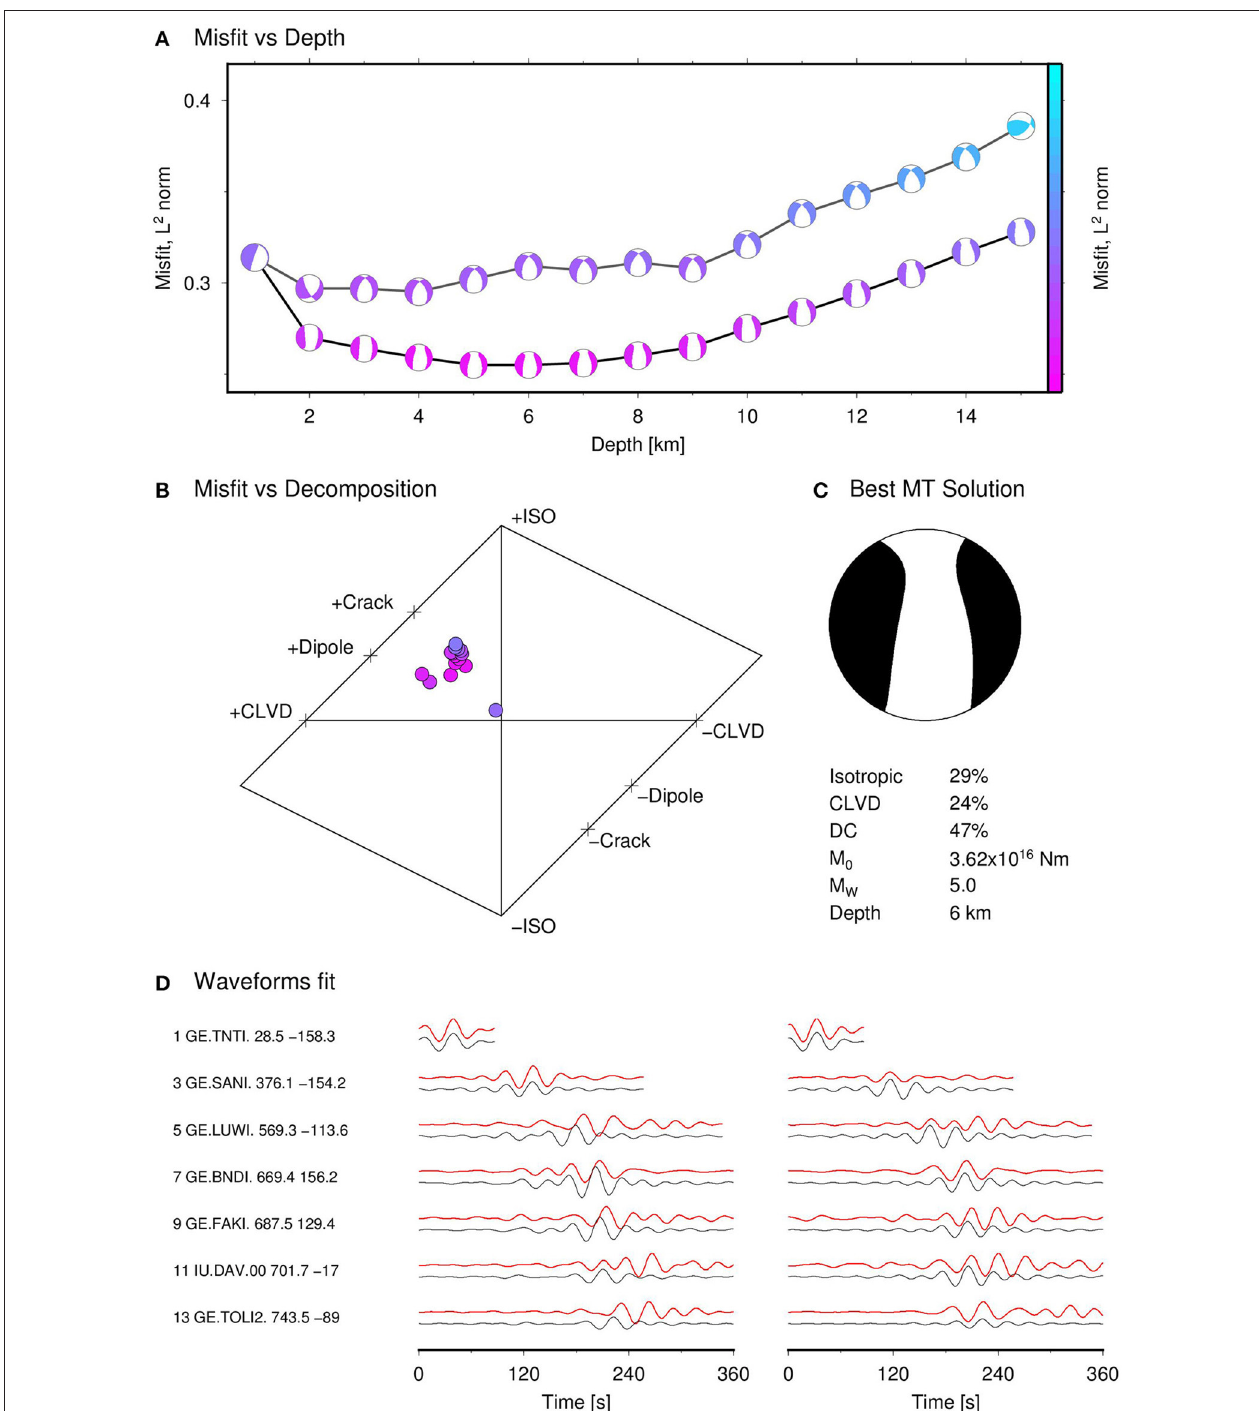
FIGURE 5 | Moment tensor inversion results for the 20 November 2015, 14:50:39 UTC, M w 5.0 event at Halmahera. (A) Full waveform amplitude spectra L2 norm misfit assuming a DC source (gray line and beach-ball ) and full MT source (black line and beach-balls), for different depths, showing a clear minimum at 6km, and a substantial improvement assuming a full MT mode . (B) Decomposition of full MT solutions for different depths (colored according to the misfit scale) show in most cases a positive tensile crack component. (C) Focal sphere of the best MT solution (deviatoric term) and list of MT parameters. (D) Comparison of full waveform displacements at regional broadband stations for vertical (left) and transverse (right) components. Station names, distance (km), and azimuth (deg) are listed on the left-hand side. Observed (red lines) and synthetic (black lines) are plotted normalized per station and component and aligned according to cross-correlation.